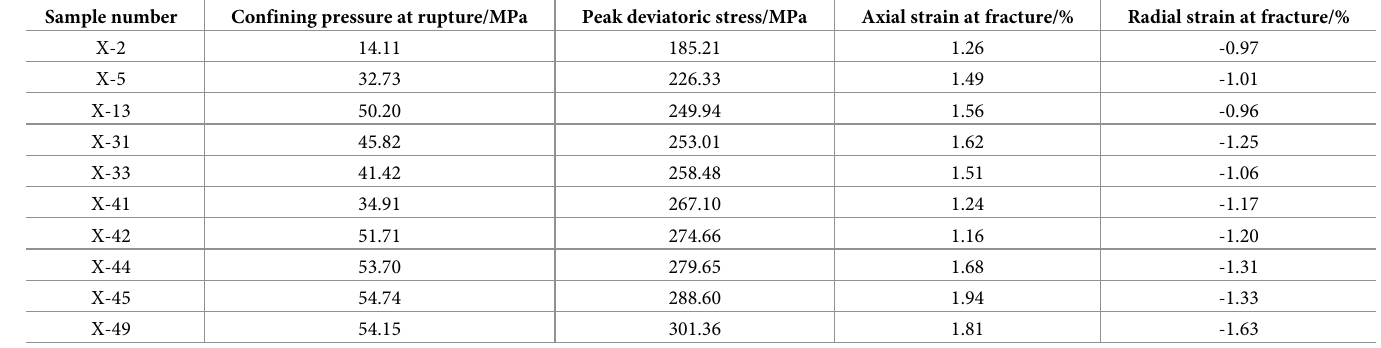
Table 3. Failure strain of shale samples under unloading confining pressure tests.